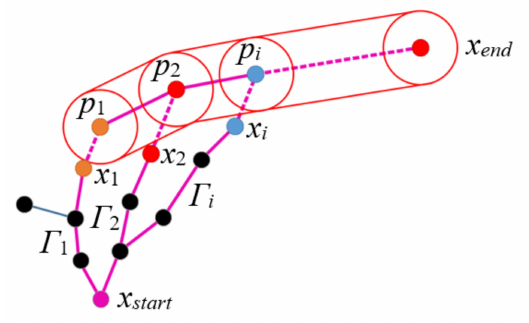
Figure 14. Different paths.